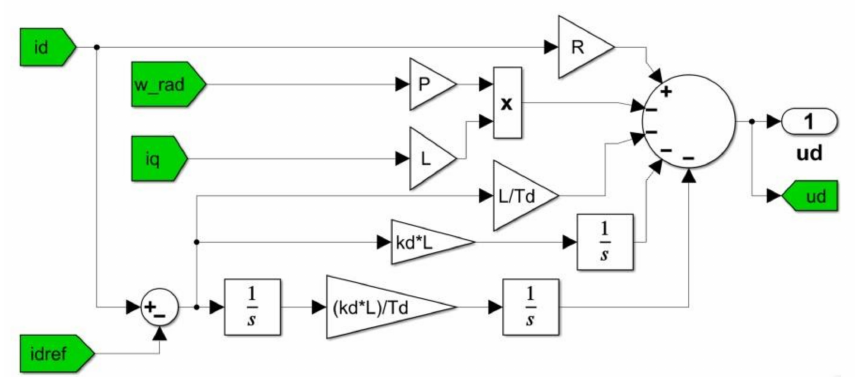
Figure 19. Block diagram of the MATLAB/Simulink implementation for the synergetic current controller of the u d command—Equation